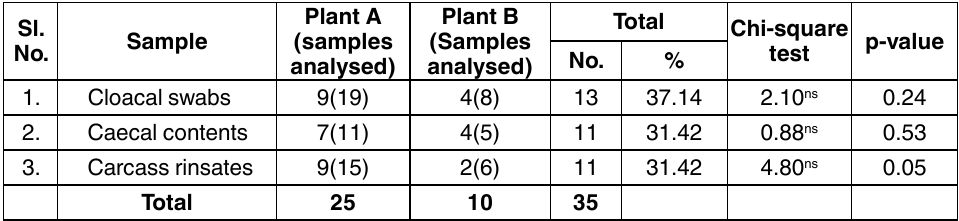
table 3 . Overall occurrence of iro B gene in Salmonella spp. isolates from both of the processing plants sl. No.